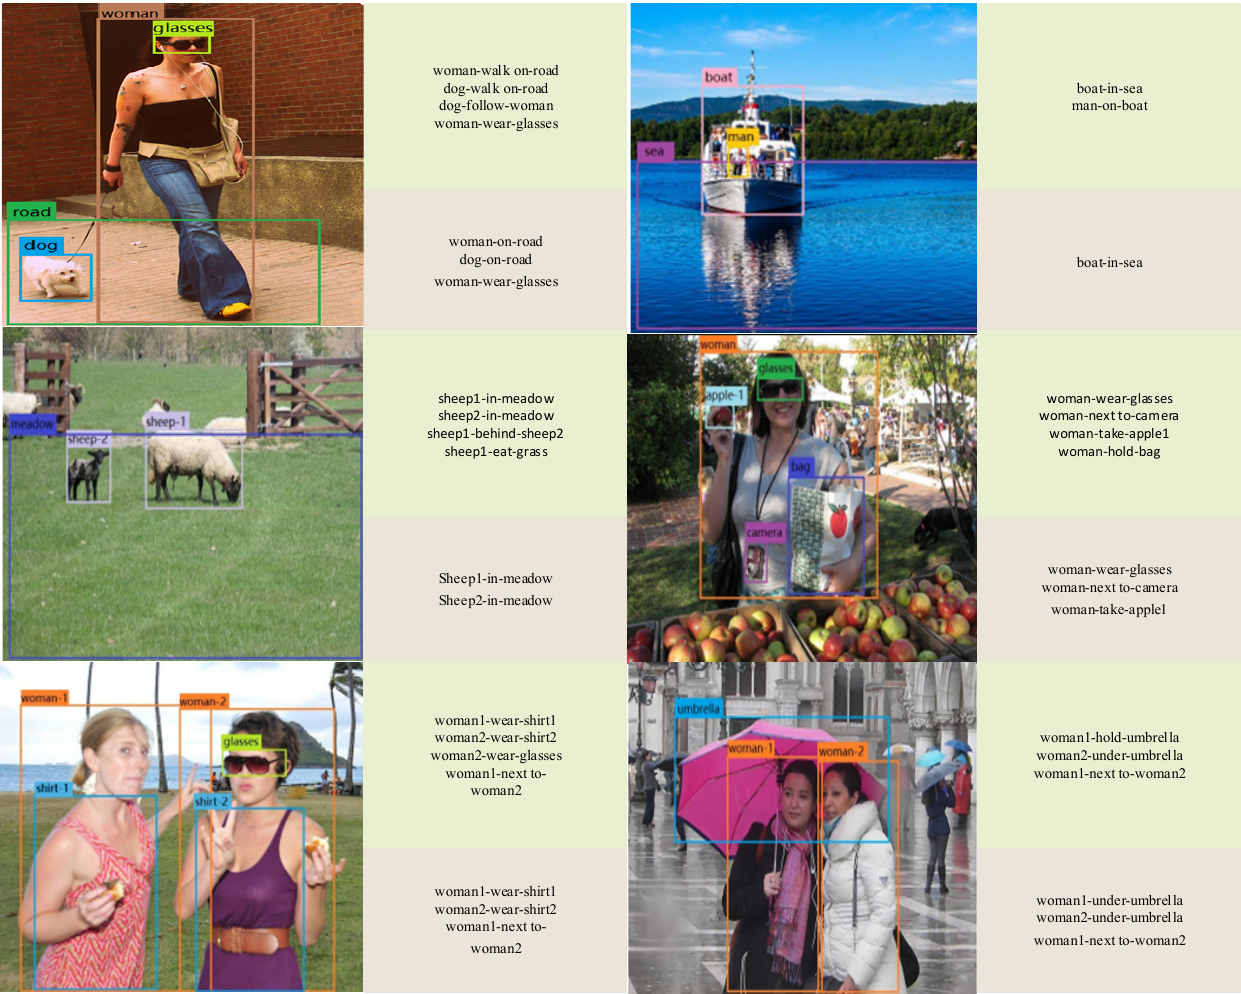
Figure 4. Qualitative results of our model on the VRD. On the right of each image, the green box shows the positive prediction in the top 50 predictions of our full model. The brown box shows that of our model without common knowledge reasoning.